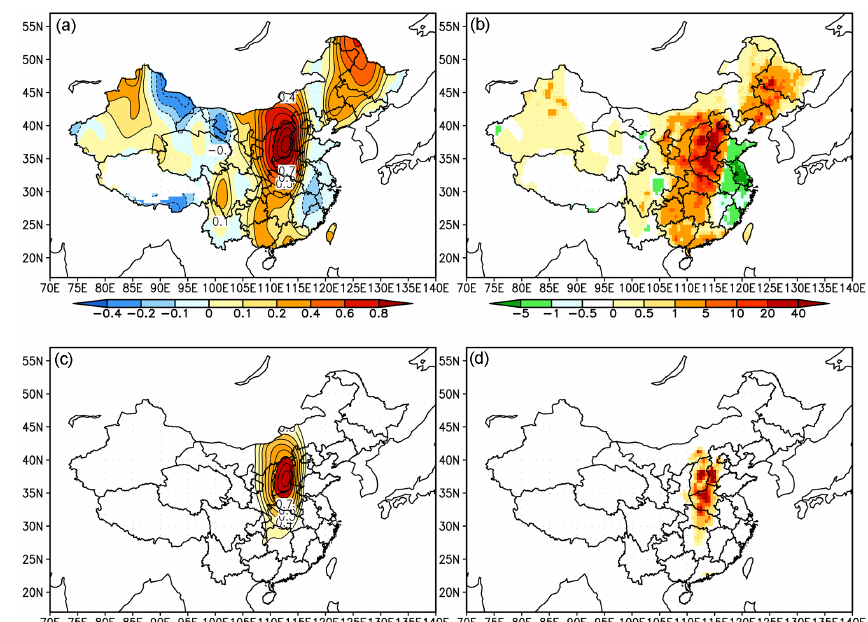
Figure 4. BC emissions inversed by observations from site Zhengzhou (ZZ): (a) back-ground error correlation between site ZZ and other grids without localization; (b) BC emissions inversed by observations from site ZZ without localization; (c) background-error correlation between site ZZ and other grids with localization; (d) BC emissions inversed by observations from site ZZ with